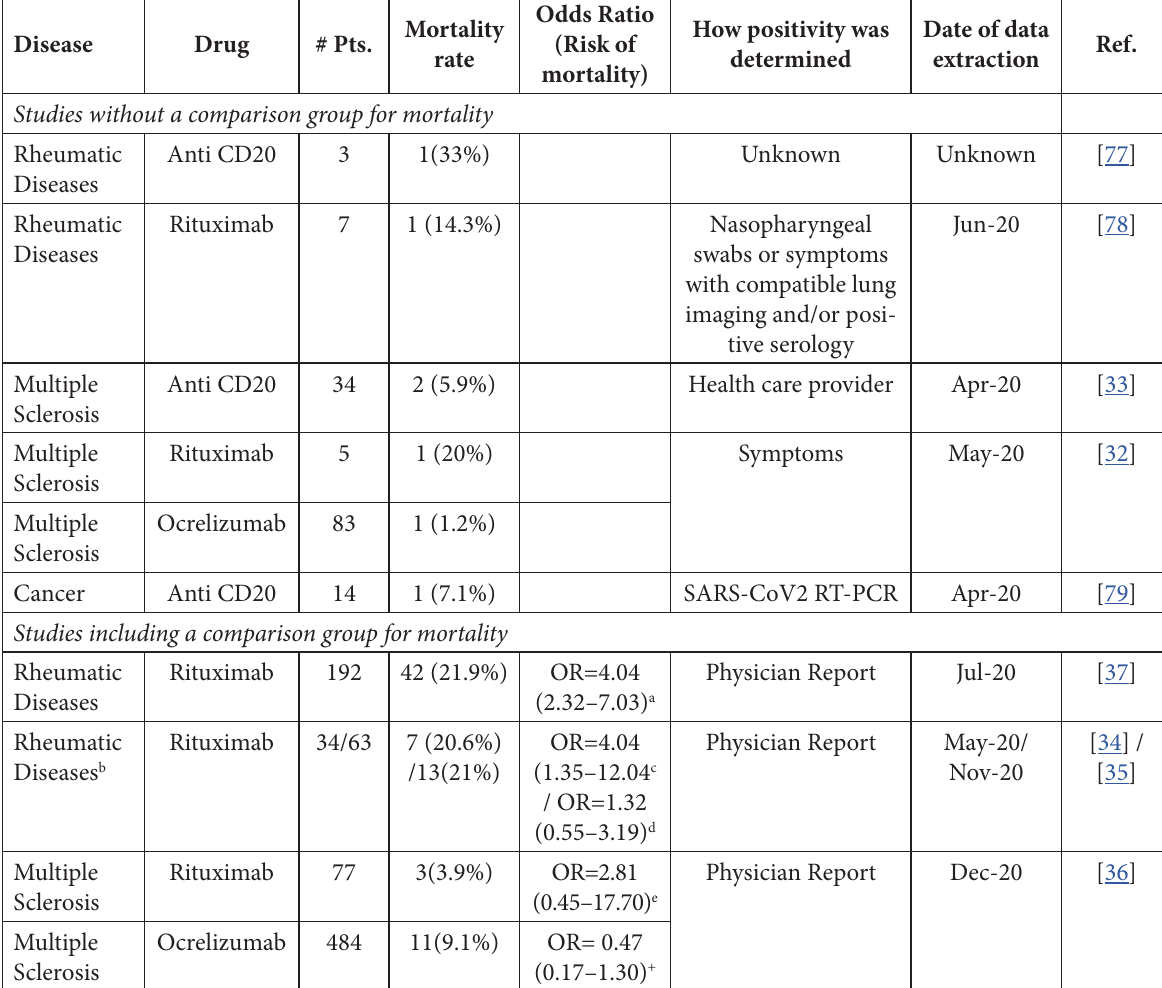
Table 3: Mortality Rate among COVID-19+ patients receiving B-cell depleting therapies Disease Drug # Pts.